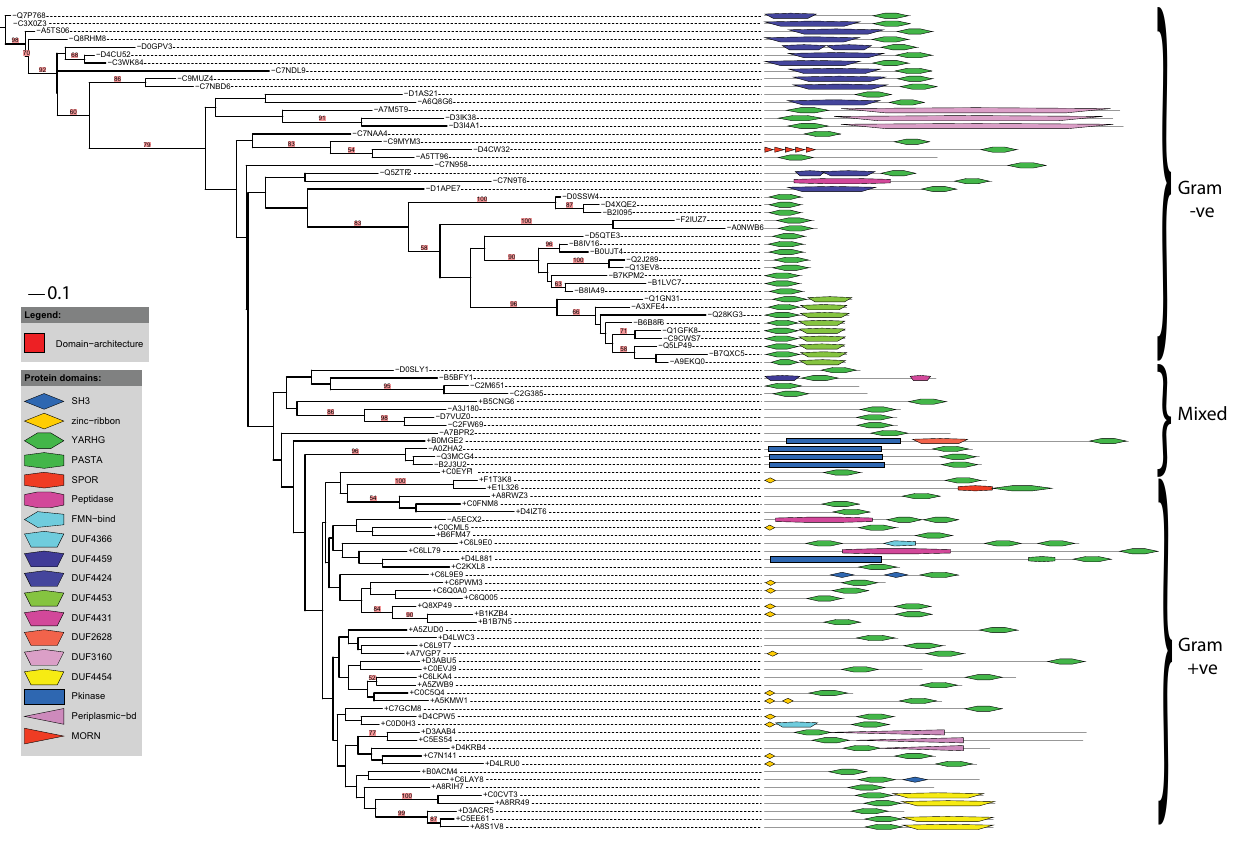
Figure 3. Phylogenetic distribution and domain-architecture of sequences carrying the YARHG domain. Phylogenetic tree of sequence- regions found in the YARHG family aligned with their relative domain-architectures. Bootstrap values . 50 are indicated. The Gram-status of each sequence is shown by the relevant ‘ + ’ or ‘ 2 ’ in front of the accession number. peptidase in A5ECX2 and a serine-peptidase for C6LL79. In